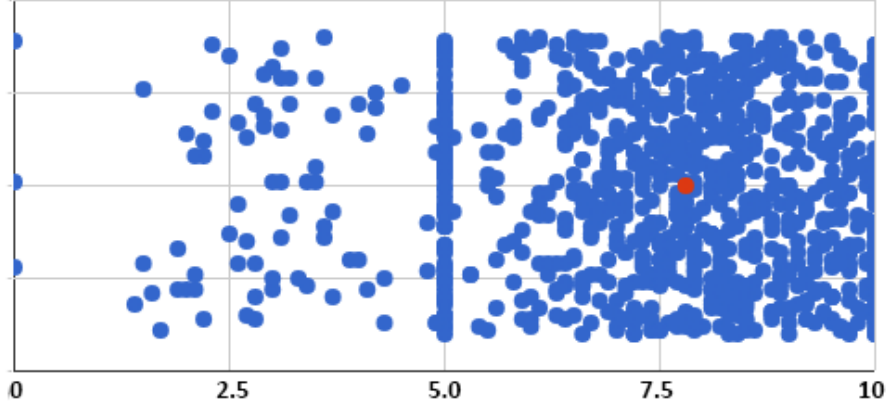
Figure 6. Scatter plot depicting visual analog scores of all study participants, demonstrating the perception of confidence in personal ability to minimize the risk of infection, with a mean of 7.51 (SD 1.93) and a median of 7.80 (red dot), and confidence that others are adhering to the Centers for Disease Control and Prevention guidelines to minimize the likelihood of COVID-19 infection spread, with 0 representing no confidence and 10 the most confidence, with a mean of 5.28 (SD 2.35) and a median of 5.0 (red